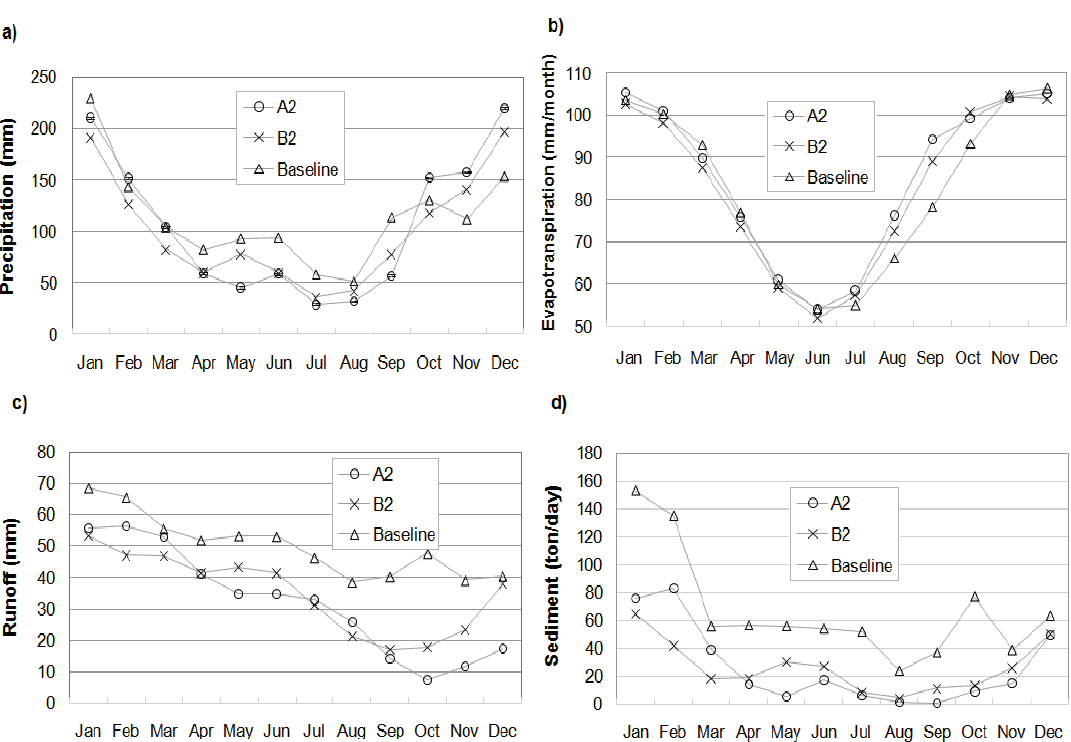
Fig. 2 Simulation results for the current climate condition and for scenarios A2 and B2: (a) Mean precipitation (mm). (b) Mean evapotranspiration (mm). (c) Mean runoff (mm). (d) Mean sediment yield (t/day).